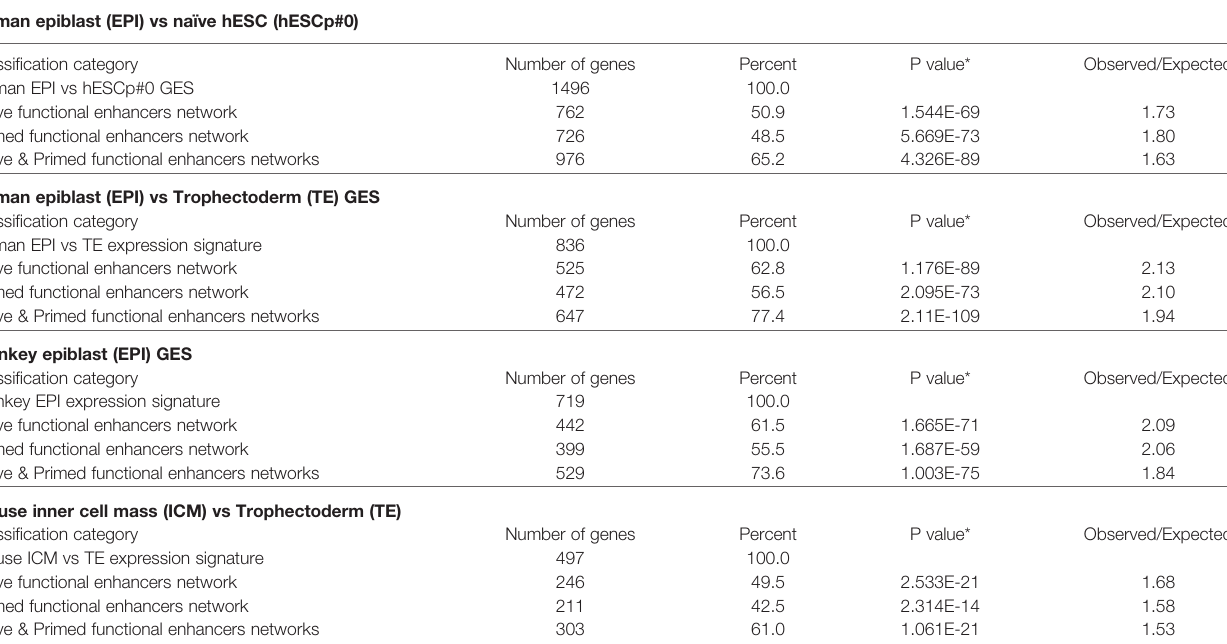
TABLE 6 | Enrichment within regulatory networks of Naïve and Primed hESC active enhancers of gene expression signatures (GES) de fi ning embryonic lineages of distinct